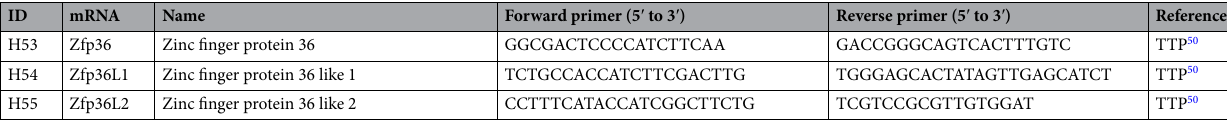
Table 1. Human qPCR primers.